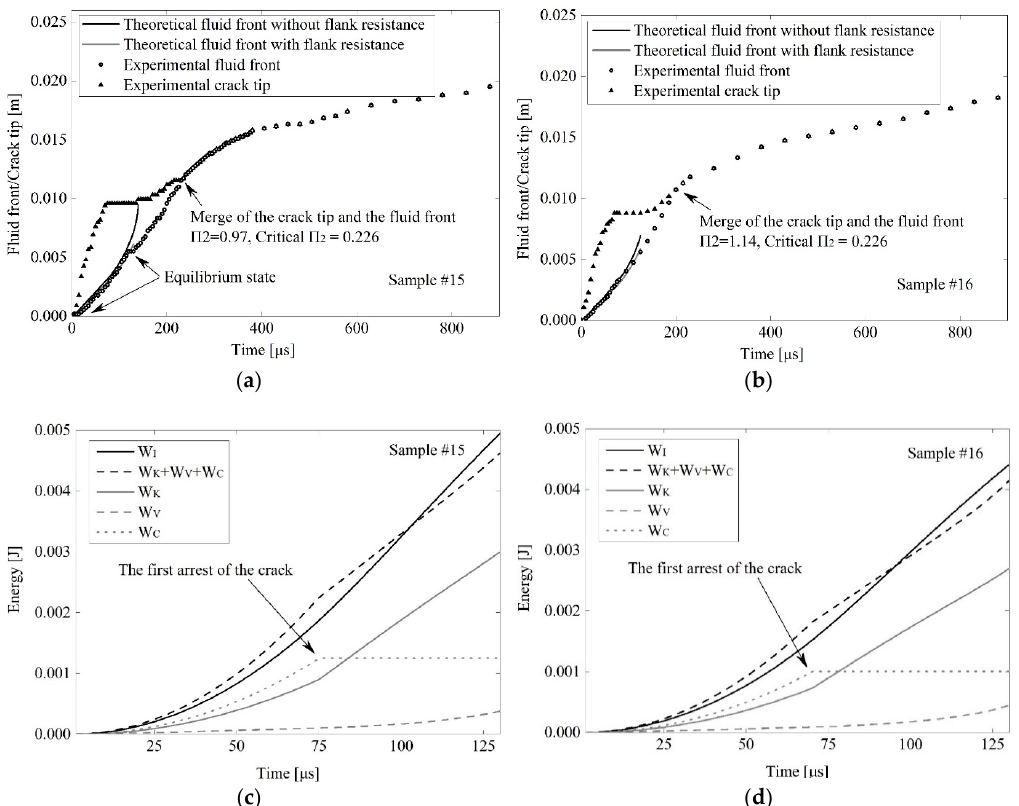
Figure 7. ( a , b ) are comparison between experimental results and theoretical results of fluid front for sample #15 (fracturing pressure: 2.64 MPa) and sample #16 (fracturing pressure: 2.53 MPa) respectively. The fluid front positions are the numerical results by solving Equation (22) with and without the term of the crack flank resistance. The calculations with the crack flank resistance term provide much more realistic results of the fluid front position; ( c , d ) are corresponding energy as a function of time. The kinetic energy W K of the fluid occupies over half of the total energy. W C stops increasing after the arrest of the crack as expected. The input energy and the consumed energy conform well to each other.